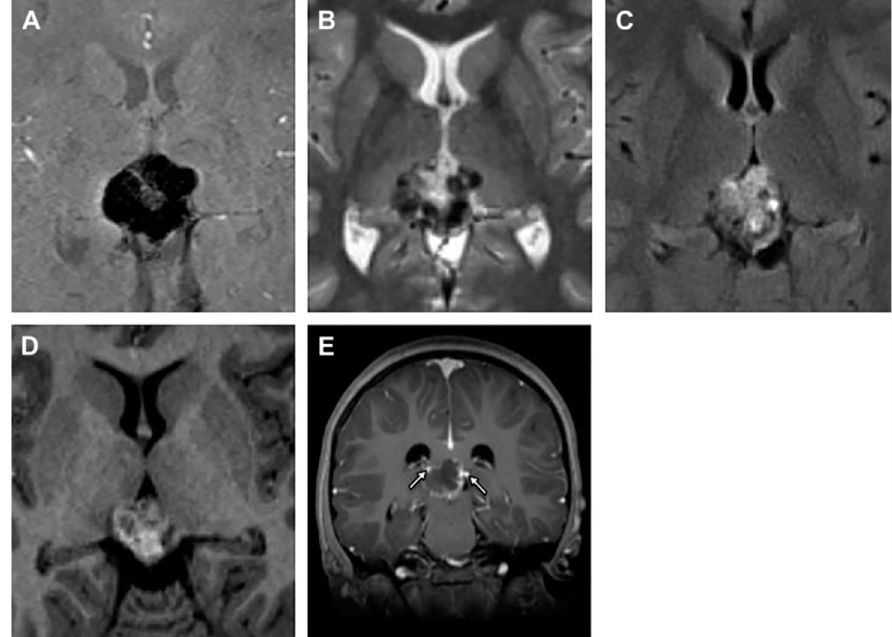
Figure 4. Pineal choriocarcinoma MRI. Susceptibility-weighted imaging ( A ), T2WI ( B ) and pineal heterogeneous mass on T1WI ( C , D ). The arrows identify the faint peripheral enhancement after the intravenous administration of gadolinium ( E ). Reprinted with permission from Causil et al. (2016) [46]. Elsevier—2021 (License Number: 5034730033295).